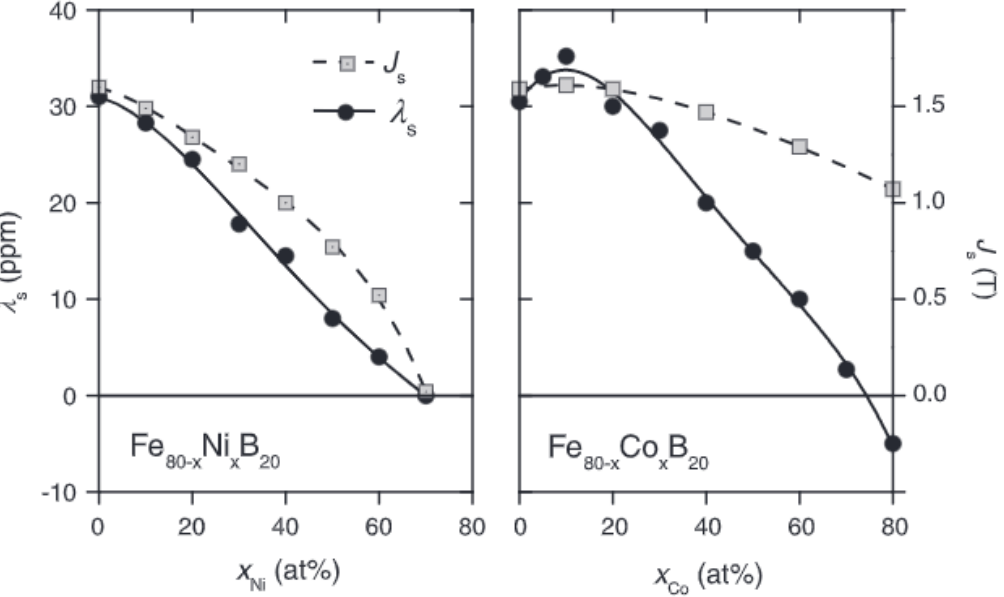
Figure 3. Saturation magnetisation J s (dashed lines) and saturation magnetostriction λ s (full lines) of amorphous Fe-Ni- based and Fe-Co-based alloys with changing Ni and Co content, respectively (reprinted with the permission from [23], Elsevier, 2013).